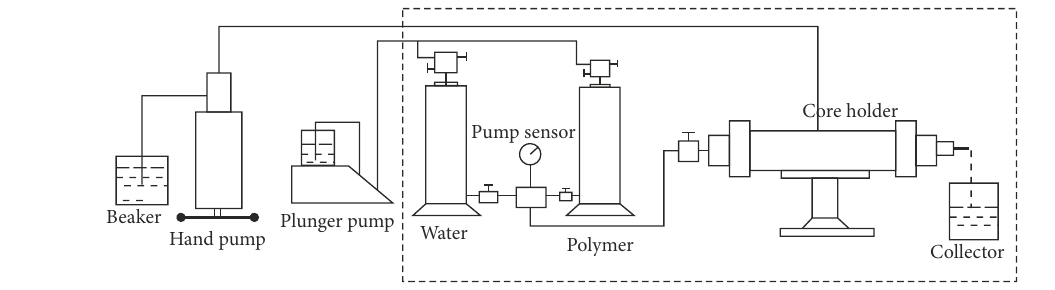
Figure 8: The flow characteristics evaluation process.